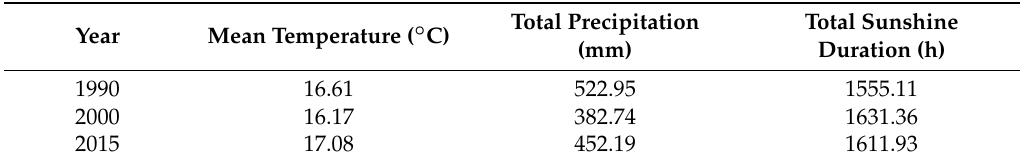
Figure 5. Irrigation ratio changes from 1990 to 2015 in Northeast China. ( a ) 1990–2000; ( b ) 2000–2015. Table 4. Average value of three meteorological factors at ten stations during the maize growth period from 1990 to 2015.